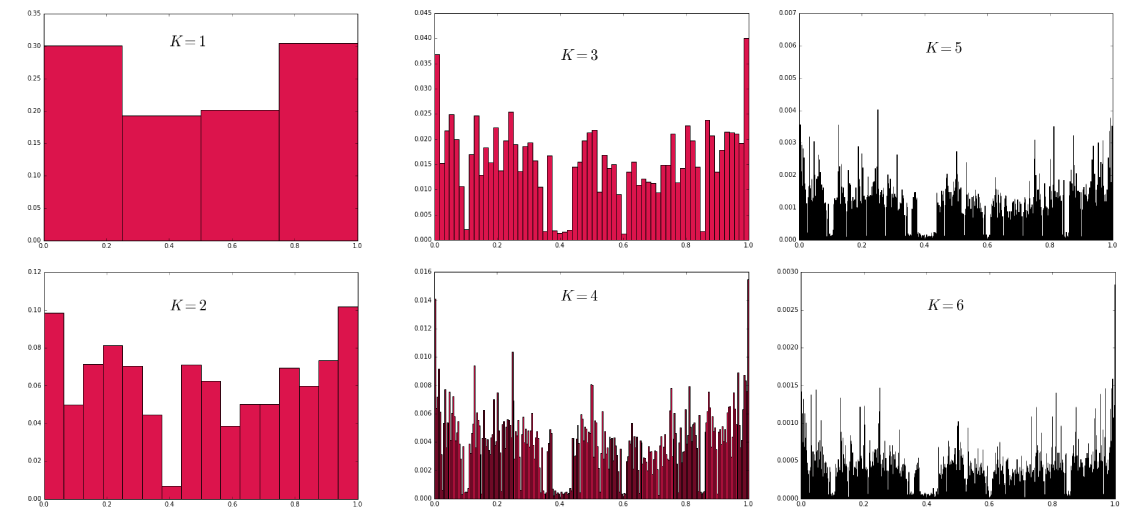
Fig. 5 21 Human chromosome histograms for R = 1 to R =